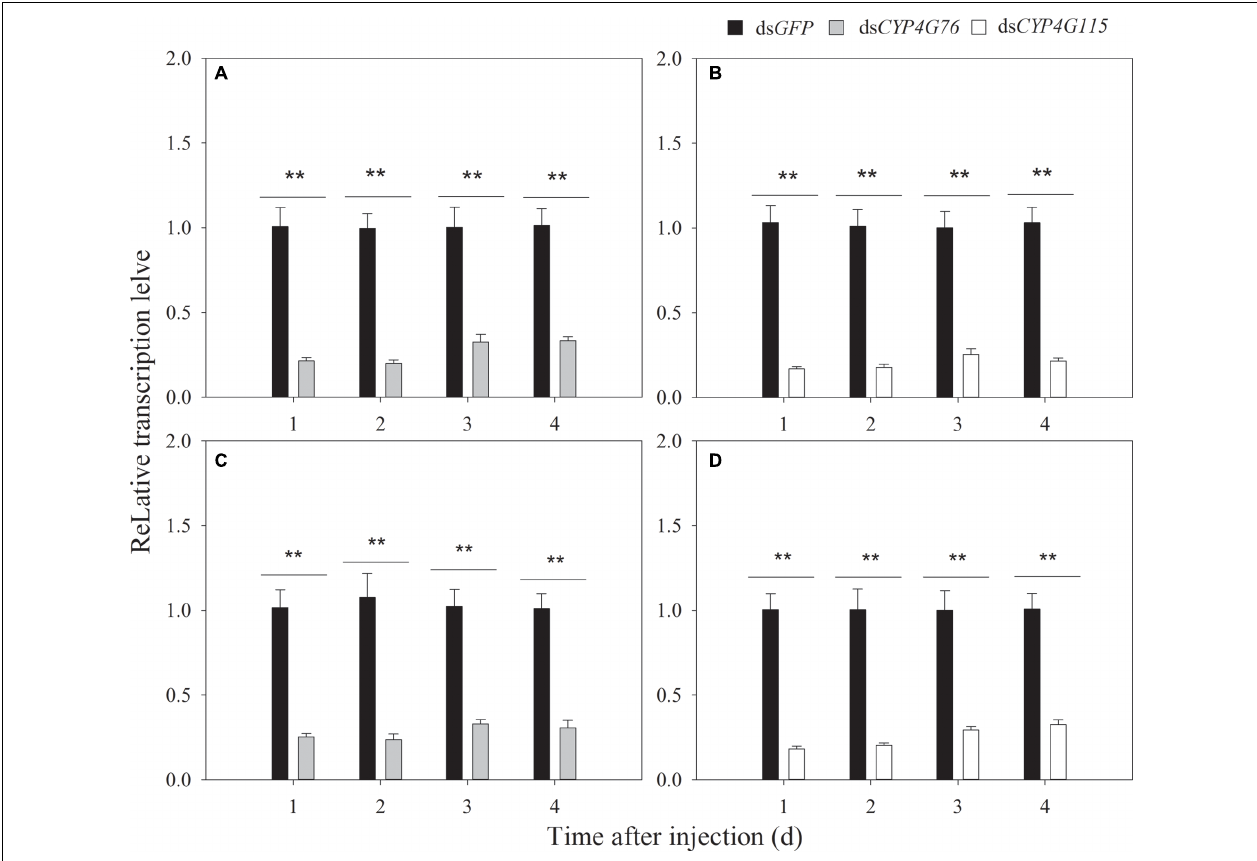
FIGURE 4 | The expression of CYP4G76 and CYP4G115 in third and fourth instar Nilaparvata lugens nymphs 1–4 days after injection of single or commingled dsRNA (40 nL, 2000 µ g · mL − 1 ). (A) Injection of CYP4G76 dsRNA, (B) Injection of CYP4G115 dsRNA, (C,D) Injection of commingled dsRNA with ds CYP4G76 and ds CYP4G115 (1:1). The CYP4G76 and CYP4G115 transcript levels were analyzed by qRT-PCR. Mean ± SE was calculated from five biological replicates, and each biological replicate contained ten third instar N. lugens nymphs. ∗∗ in each figure showed significant difference between treatments and control at each time point (Student’s t -test, p <